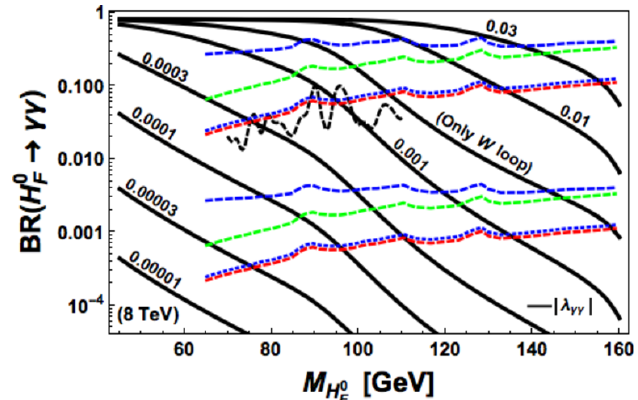
Figure 2 . The top set of dashed colored lines are the same as in (cid:12)gure 1. The lower colored dashed lines (neglecting CMS search) are the same as the top, but projected assuming a two orders of magnitude improvement in sensitivity. The black solid lines indicate contours of the e(cid:11)ective coupling ratio (cid:21) (cid:13)(cid:13) de(cid:12)ned in eq. (2.5). We also indicate the contour corresponding to only the W loop contribution to the e(cid:11)ective